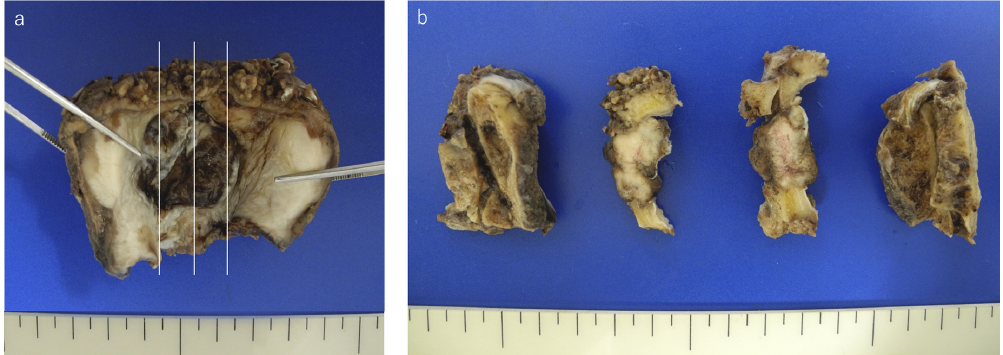
Figure 1. Macroscopic view of the tumor. ( a ) The gross resected specimen formed ulcer in hard palate. ( b ) The tumor was a lobulated and white-gray colored tumor.